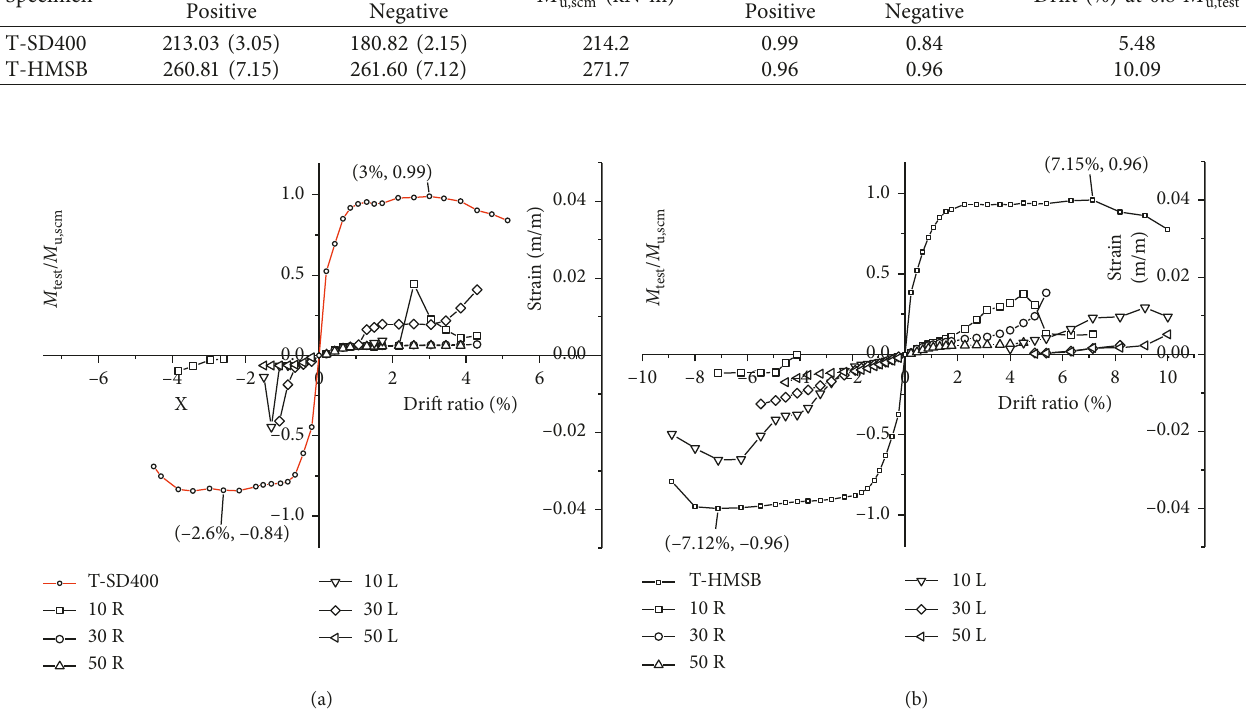
M u , test / u , scm drift curve: (a) T-SD400 and (b)